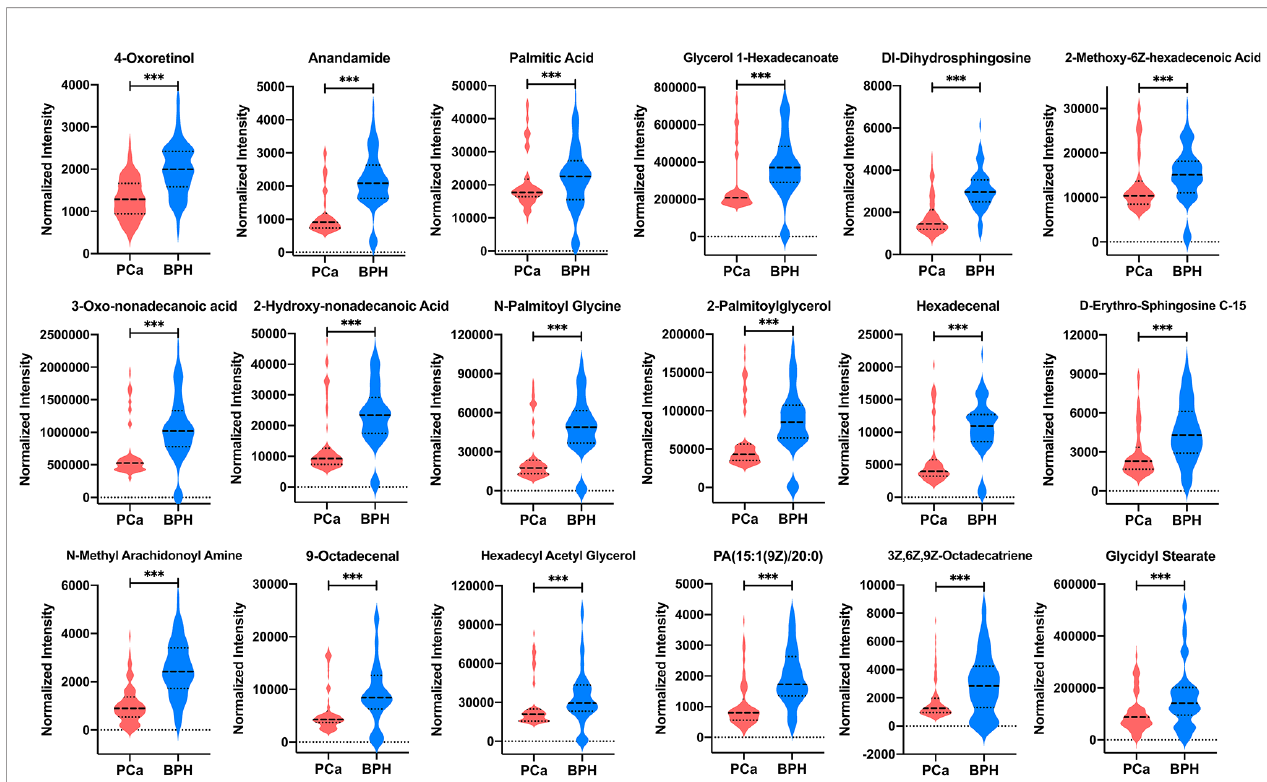
FIGURE 5 | The normalized intensity peak areas of 18 differential metabolites in PCa and BPH groups. *** p < 0.001. PCa, prostate cancer; BPH, benign prostatic hyperplasia.